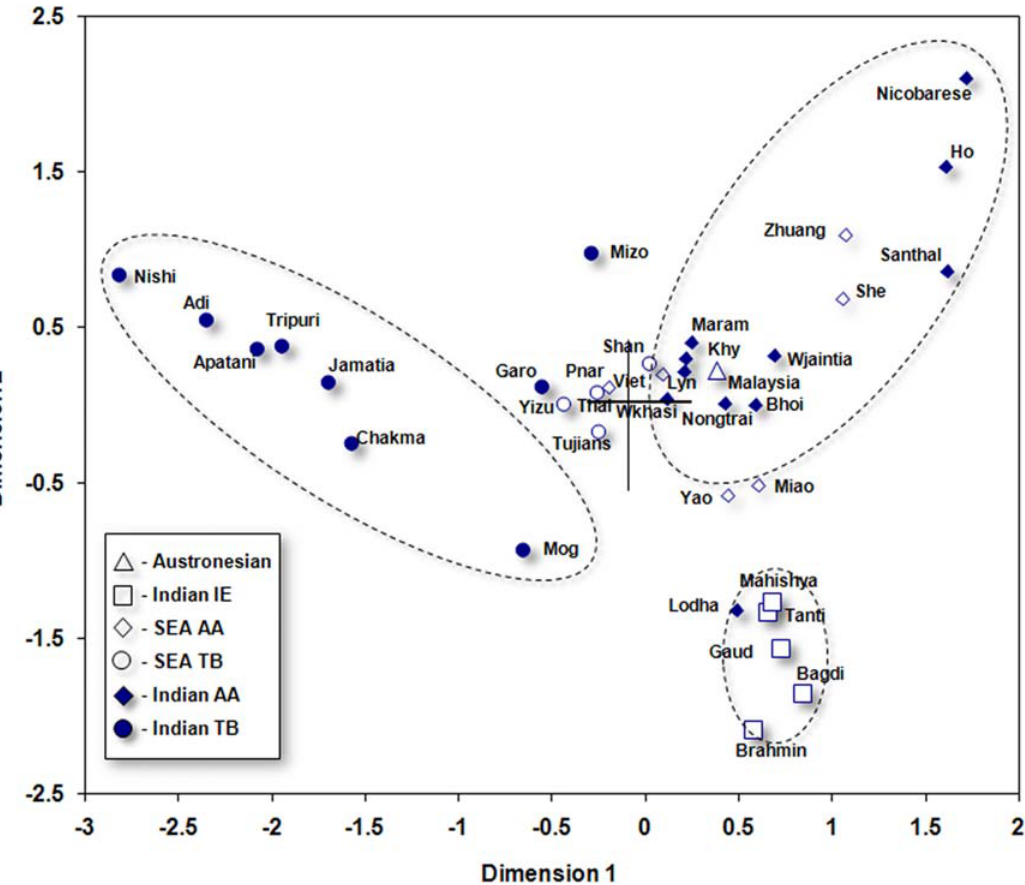
Figure 3. Plot on the first two dimensions derived from the multidimensional scaling of the pairwise F ST distances of the populations based on Y-haplogroups. Reference to comparative data is given at Table 5. SEA, Southeast Asian; AA, Austro-Asiatic; IE, Indo-European, TB, Tibeto-Burman; Khy, Khynriam; Lyn, Lyngngam; Wkhasi, War Khasi; Viet, Vietnamese; doi:10.1371/journal.pone.0001141.g003 Brahmins of Uttar Pradesh, India [16] and in the two populations of South India [20]. It is interesting to note that all the samples of this